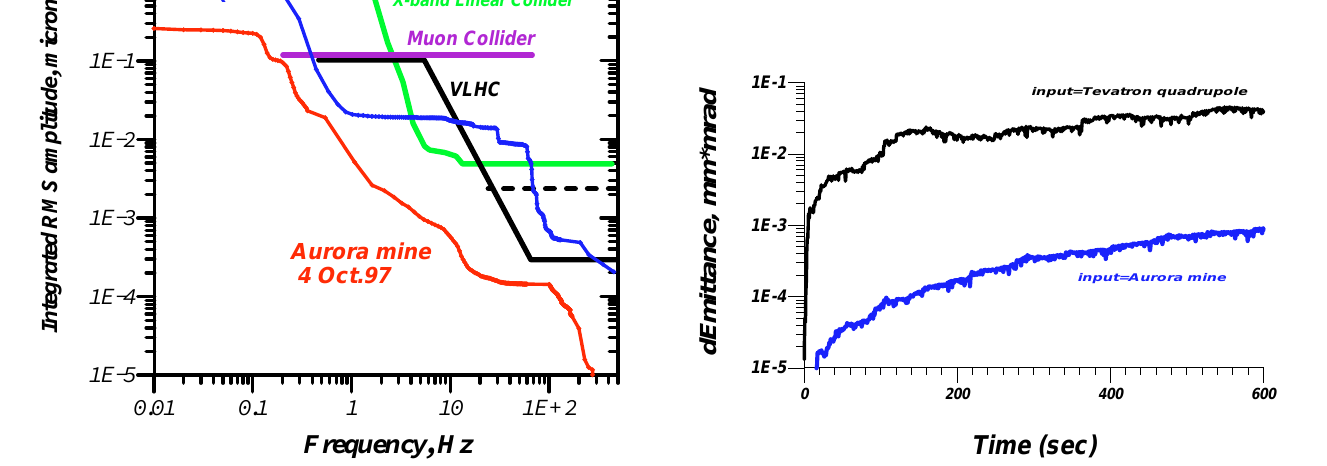
FIG. 18. (Color) Comparison of the measured ground and quadrupole vibration amplitudes with tolerances for the muon collider, X-band linear collider, and the VLHC.